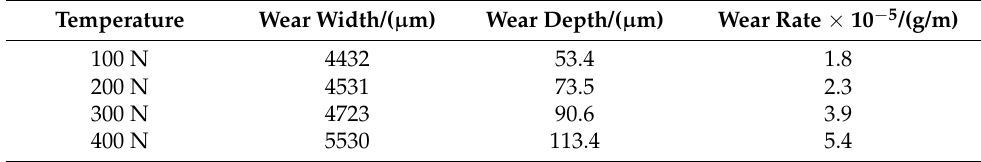
Table 4. Wear width, wear depth and wear rate of coatings at various